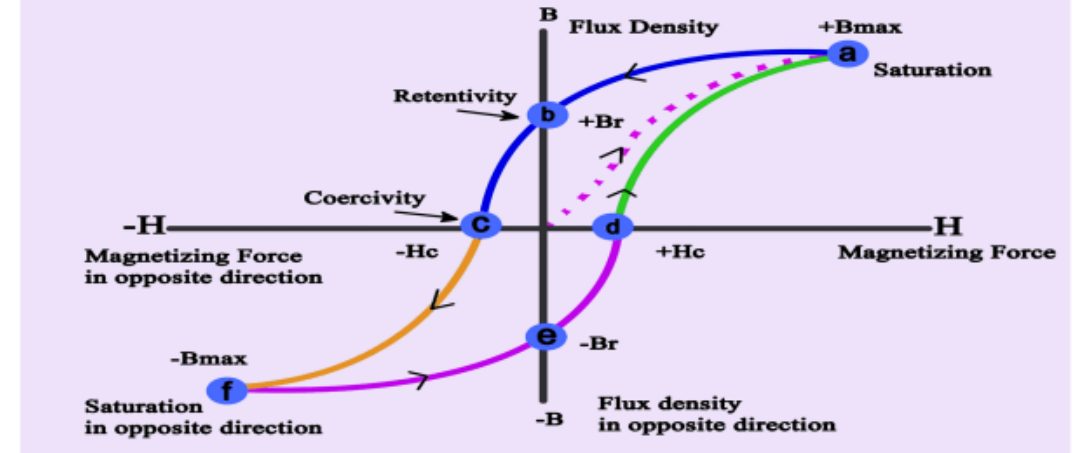
Figure 1. Hysteresis loop of magnetic material.